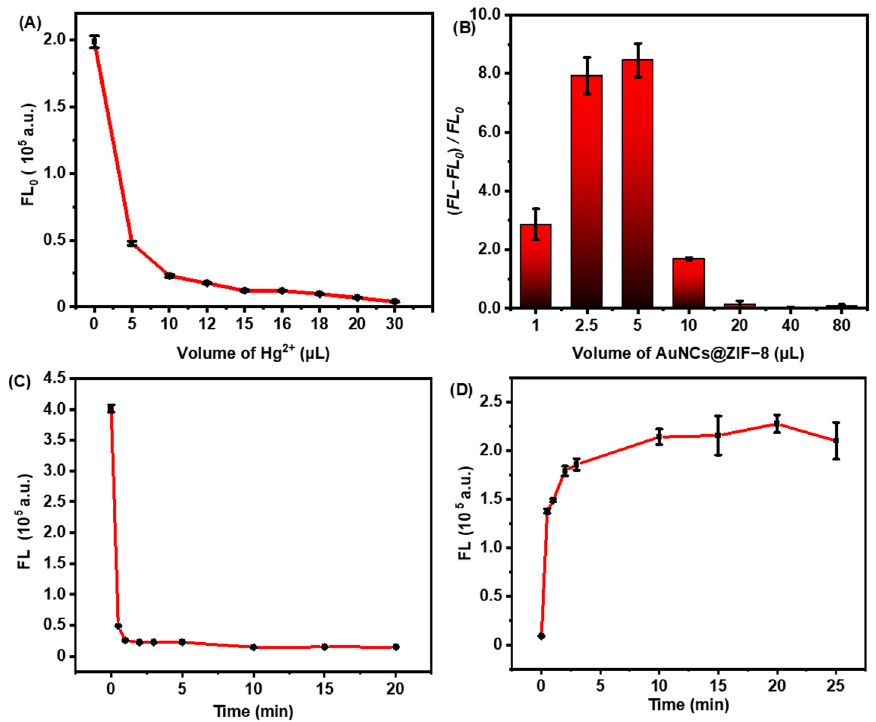
Figure 3. Fluorescence changes of as-prepared sensing probes. ( A ) The fluorescence intensity of AuNCs@ZIF-8 at 400 nm wavelength with different concentrations of Hg 2+ . ( B ) Fluorescence changes of the same concentration of Cys detected by different volumes of AuNCs@ZIF-8. ( C ) Relationship between the fluorescence intensity of AuNCs@ZIF-8 and time for adding Hg 2+ ions. ( D ) Relationship between the fluorescence intensity of AuNCs@ZIF-8/Hg 2+ and time for adding Cys. Figure 3C,D plotted the time-dependent fluorescence quenching of AuNCs@ZIF-8 to Hg 2+ ions and fluorescence restoration of the probe of AuNCs@ZIF-8/Hg 2+ to Cys mole- cules, respectively. The fluorescence intensity of AuNCs@ZIF-8 particles was significantly